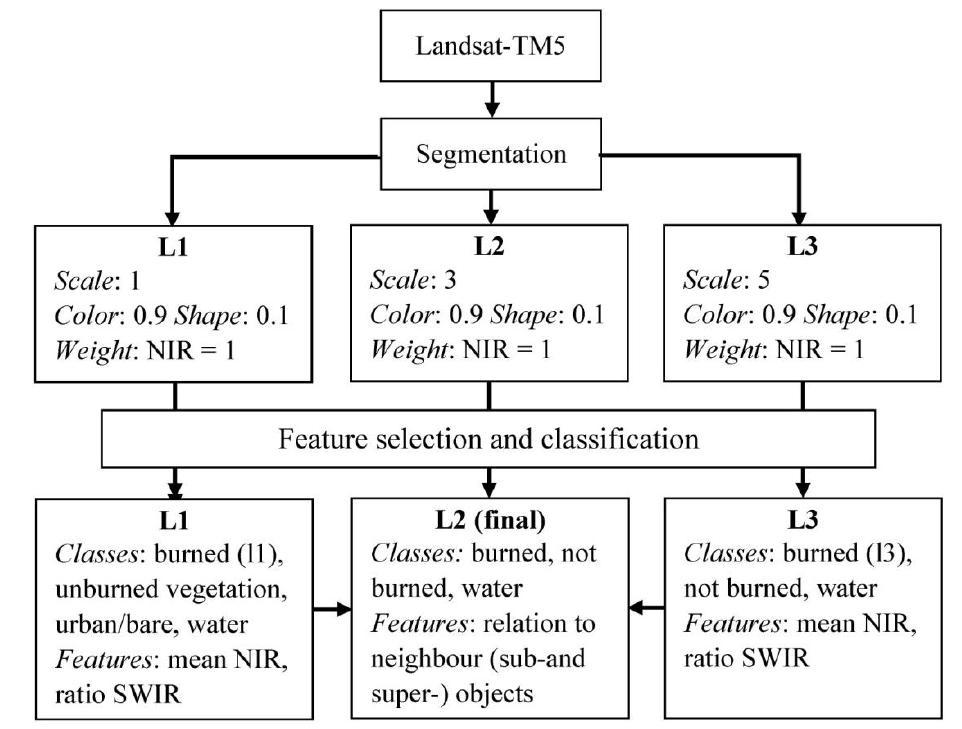
Figure 2. Flowchart of the methodology steps followed for the development of the GEOBIA classification model. This was initially developed with the use of the TM image. Minor modifications were performed when applied to the other Landsat